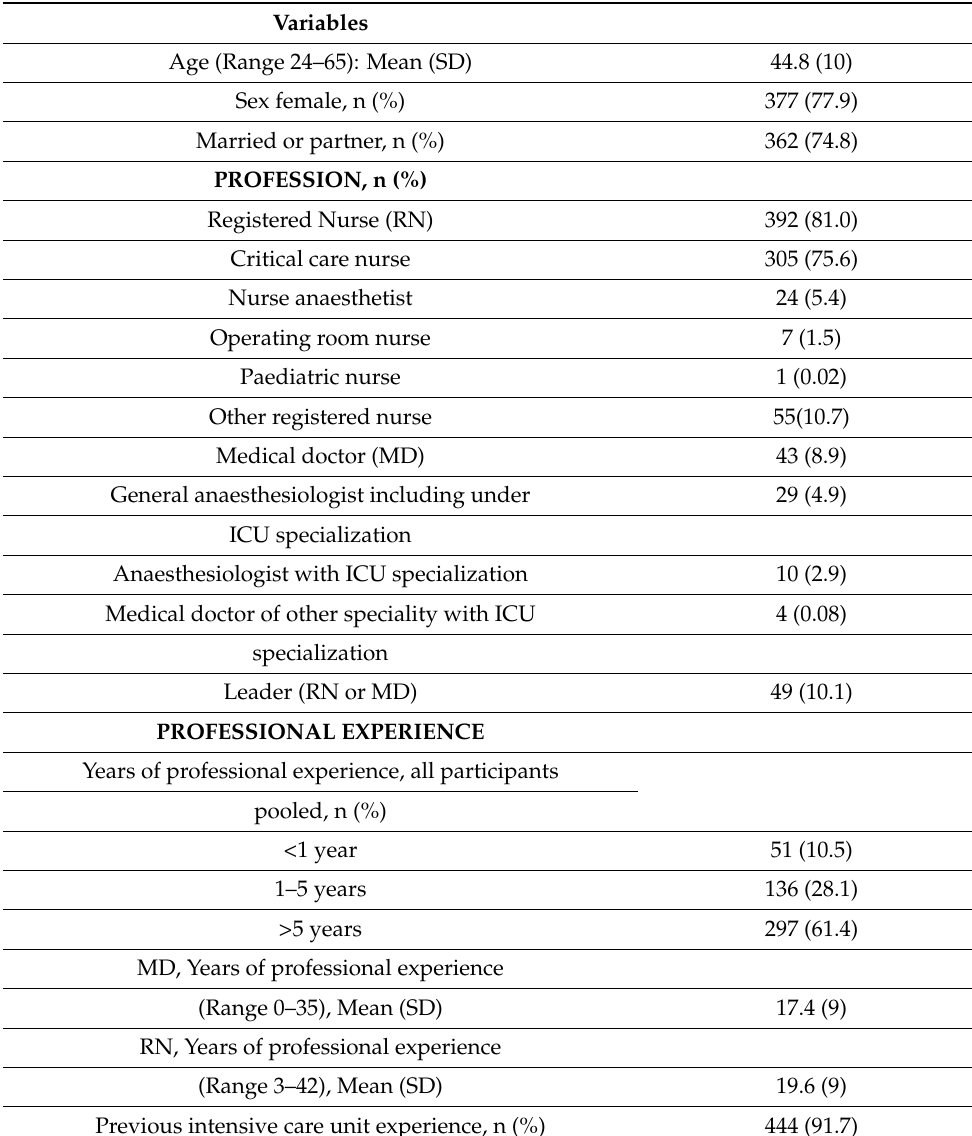
Table 1. Pre-COVID-19 demographic characteristics of respondents’ professional background in the Norwegian ICUs (N =